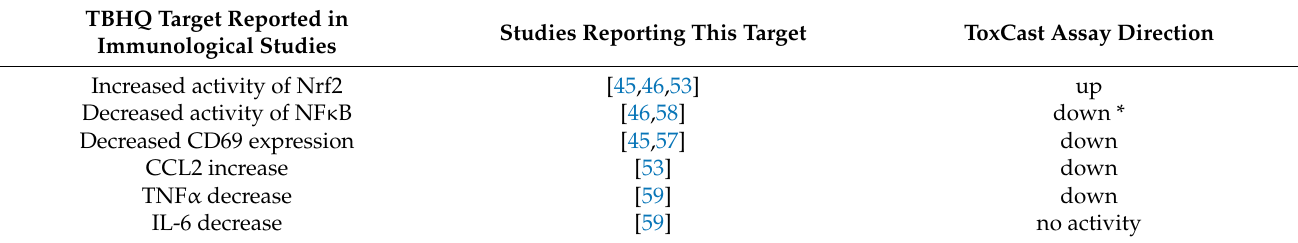
Table 6. Cellular and molecular targets affected by TBHQ that have ToxCast